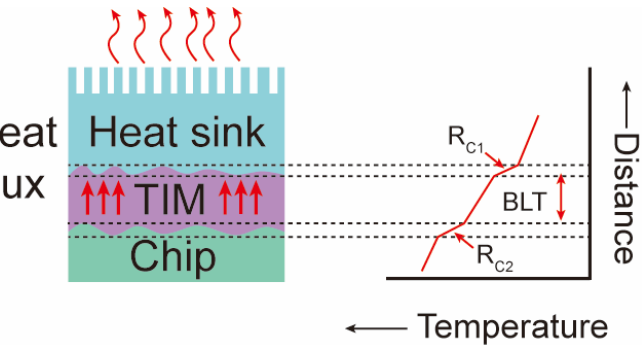
Figure 2. Schematic diagram of heat dissipation and interfacial thermal resistance in high-power